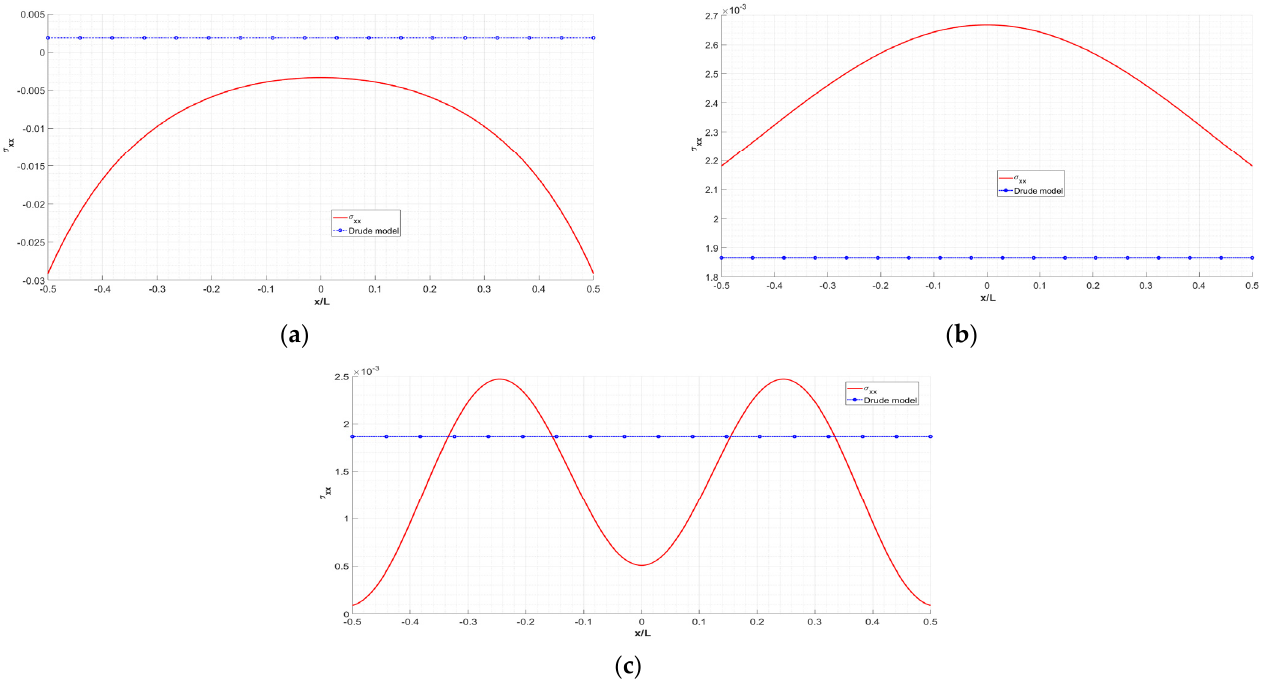
Figure 6. The spatial distribution of the conductance in the units G Drude / Ll for different values of length and µ = 0.1 eV; ( a ) L = 2 nm (single-mode regime; edge mode); ( b ) L = 10 nm (single-mode regime; bulk mode); ( c ) L = 50 nm (three-mode regime; all modes are of bulk type).